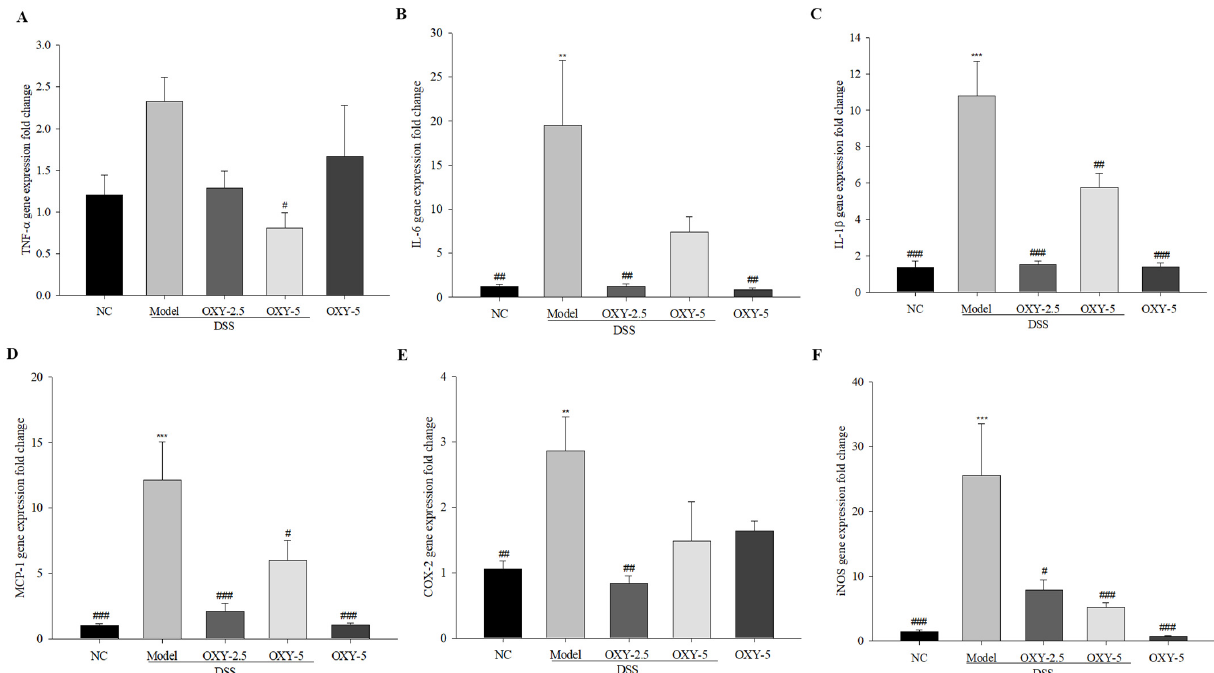
Figure 5. Effect of OXY on the gene expression of pro-inflammatory cytokines and enzymes ( n = 8/group). The mRNA expression levels of pro-inflammatory cytokines and enzymes were determined via quantitative real-time polymerase chain reaction (qPCR) ( A ‒ F ). NC, normal control group; model, DSS-induced colitis model group; DSS + OXY-2.5, DSS-induced colitis rats treated with OXY (2.5 mg/kg) group; DSS + OXY-5, DSS-induced colitis rats treated with OXY (5 mg/kg) group; OXY-5, rats treated with OXY (5 mg/kg) alone group. The values are expressed as mean ± SEM. Significant differences among groups were evaluated via ANOVA with Tukey’s post hoc HSD. ** p < 0.01 and *** p < 0.001 compared with the NC group; # p < 0.05, ## p < 0.01, and ### p < 0.001 compared with the model group.